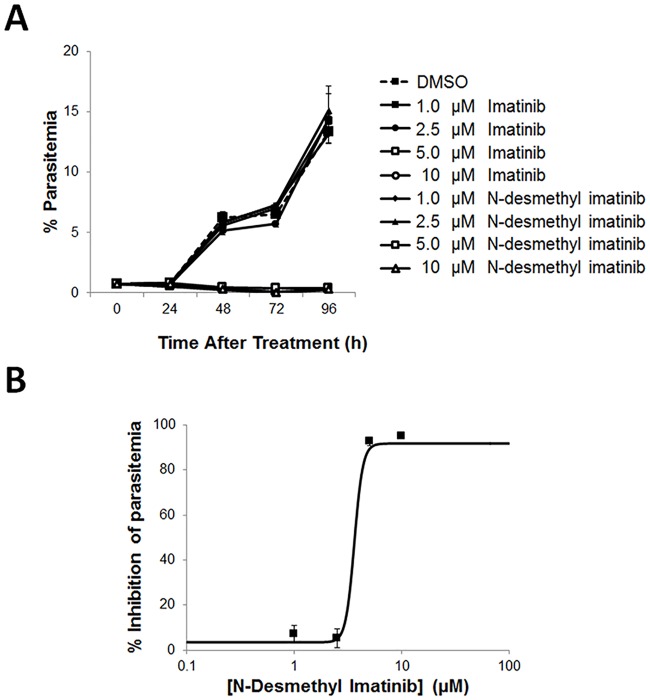
Effect of the primary imatinib metabolite in humans, N-desmethyl imatinib, on inhibition of P. falciparum parasitemia.P. falciparum strain Palo Alto cultures were treated during ring stage (0.5% parasitemia) with increasing concentrations of (A) imatinib or N-desmethyl imatinib, and % parasitemia of infected cultures was determined by flow cytometry every 24 hours after treatment to monitor parasite replication. Note, open markers inhibited all parasitemia. (B) To create a dose response curve, cultures were treated with concentrations of N-desmethyl imatinib, and the % inhibition of parasitemia was determined by flow cytometry after a 60 h incubation.